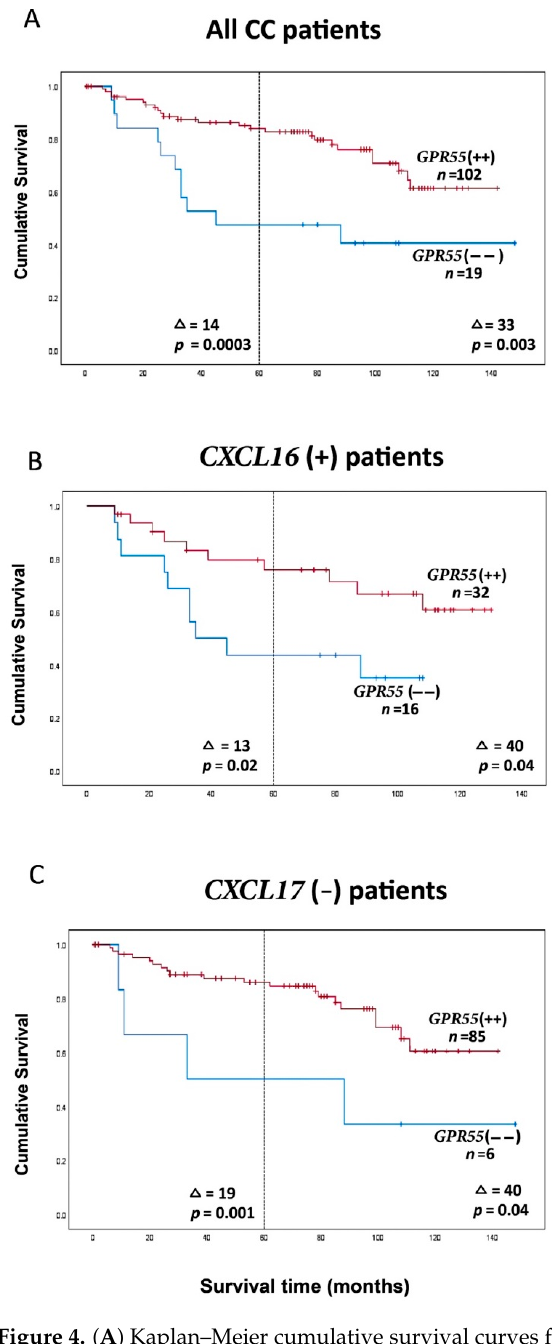
Figure 4. ( A ) Kaplan–Meier cumulative survival curves for GPR55( −− ) and GPR55(++) patients. All 121 CC patients are included. Each patient is represented by the lymph node with the lowest GPR55 mRNA value. A GPR55 mRNA/ CEA mRNA ratio of 0.1481 was used to divide the patients into two groups. ( B ) Kaplan–Meier cumulative survival curves for GPR55( −− ) and GPR55(++) patients. The analysis is restricted to patients with CXCL16 mRNA levels in the highest lymph node > 7.2 mRNA copies/18S rRNA unit. The number of patients was 48. A GPR55 mRNA/CEA mRNA ratio of 0.1481 was used to divide the patients into two groups. ( C ) Kaplan–Meier cumulative survival curves for GPR55( −− ) and GPR55(++) patients. The analysis is restricted to the CXCL17 mRNA levels in the highest lymph node < 0.0014 mRNA copies/18S rRNA unit. The number of patients was 91. A GPR55 mRNA/CEA mRNA ratio of 0.1481 was used to divide the patients into two groups. The patients were followed for 12 years. Differences in disease-free survival time after surgery between the two groups are given as a ∆ -value in months and statistical significance as p -values; n = number of patients in the respective